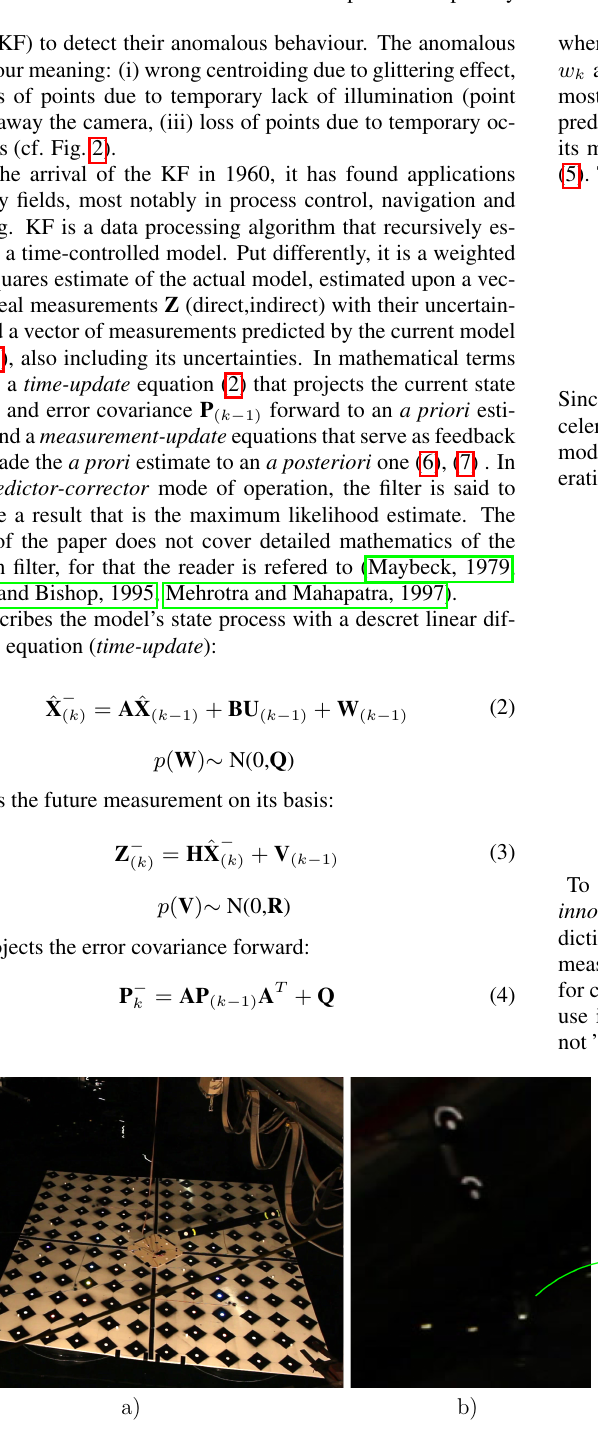
Figure 2: Reasons for lost tracking; a) temporary occlusions, b-d) point’s normal moving away from camera’s Line of